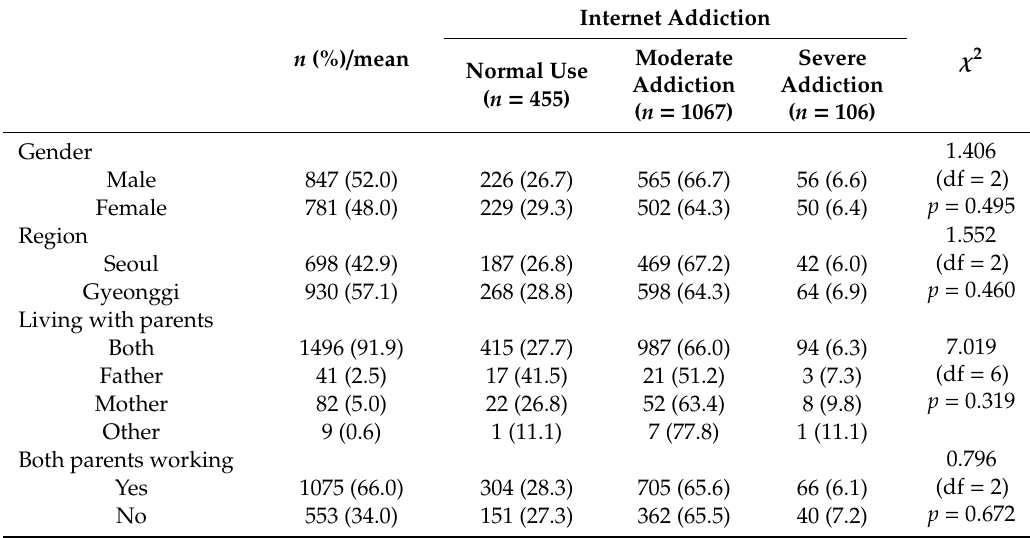
Table 1. Sociodemographic characteristics ( N =